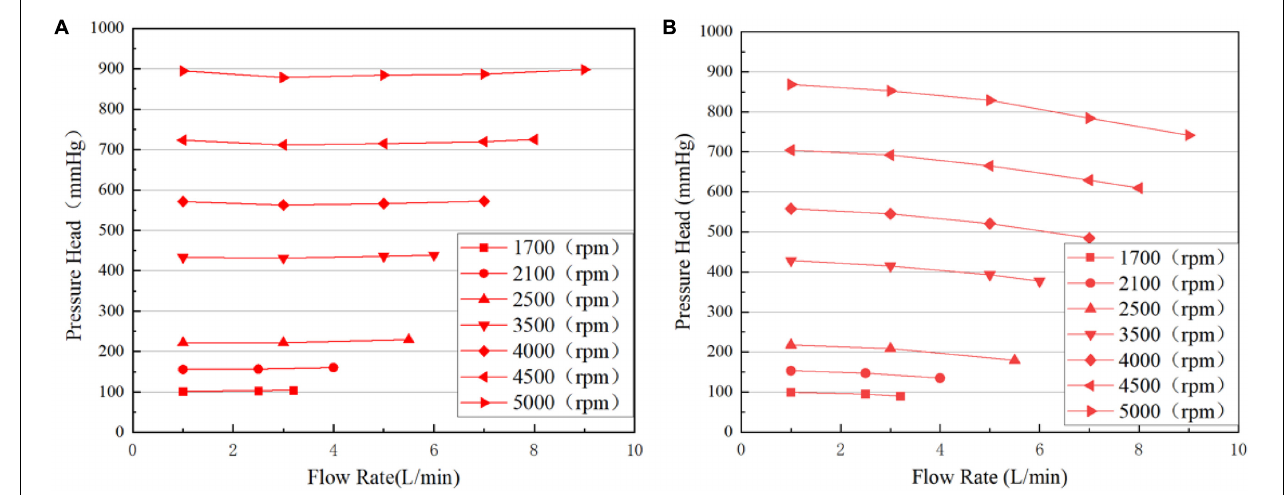
FIGURE 4 | Predicted H-Q curves: (A) baseline blood pump; (B) portable blood pump.